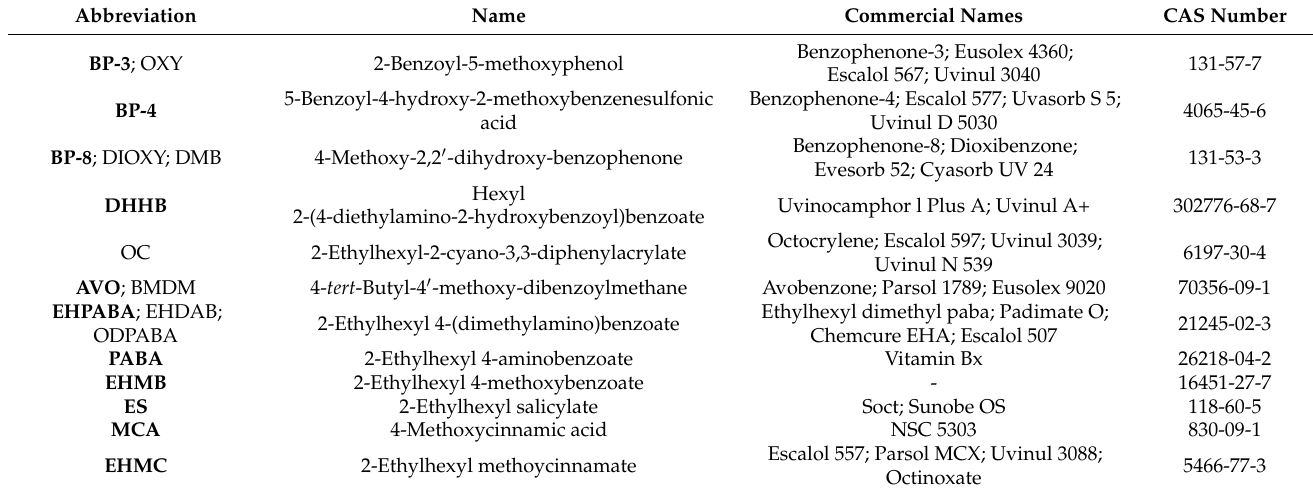
Table 1. Abbreviation, name, commercial name, and CAS number of sunscreens.